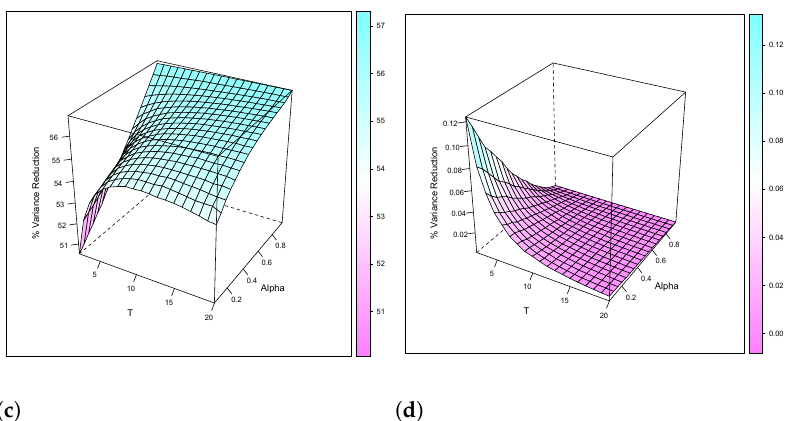
Figure 1. Reduction (%) in the variance of RML( α 0 ) gained by the optimal SLS( α 0 ). ( a ) Stationary, ε it | η i , y i 0 ∼ χ 2 . ( b ) Stationary, ε it | η i , y i 0 ∼ t ( 5 ) . ( c ) Nonstationary, ε it | η i , y i 0 ∼ χ 2 ( 1 ) ary, ε it | η i , y i 0 ∼ t ( 5 )